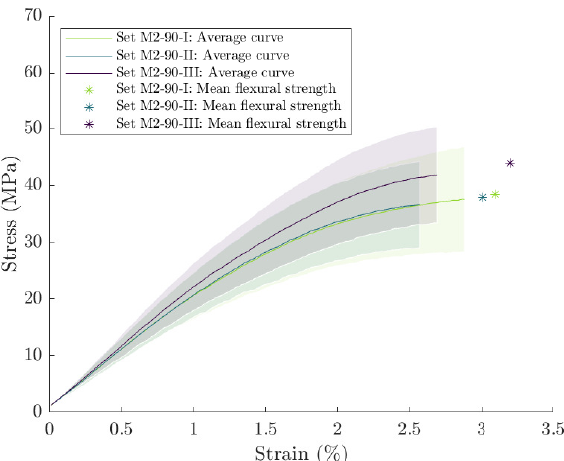
Figure 10. Bending test of CF/PA6 in the transverse direction (90° fiber direction): Average stress- strain curves with standard deviation (shadow) and flexural strength (*) for each test